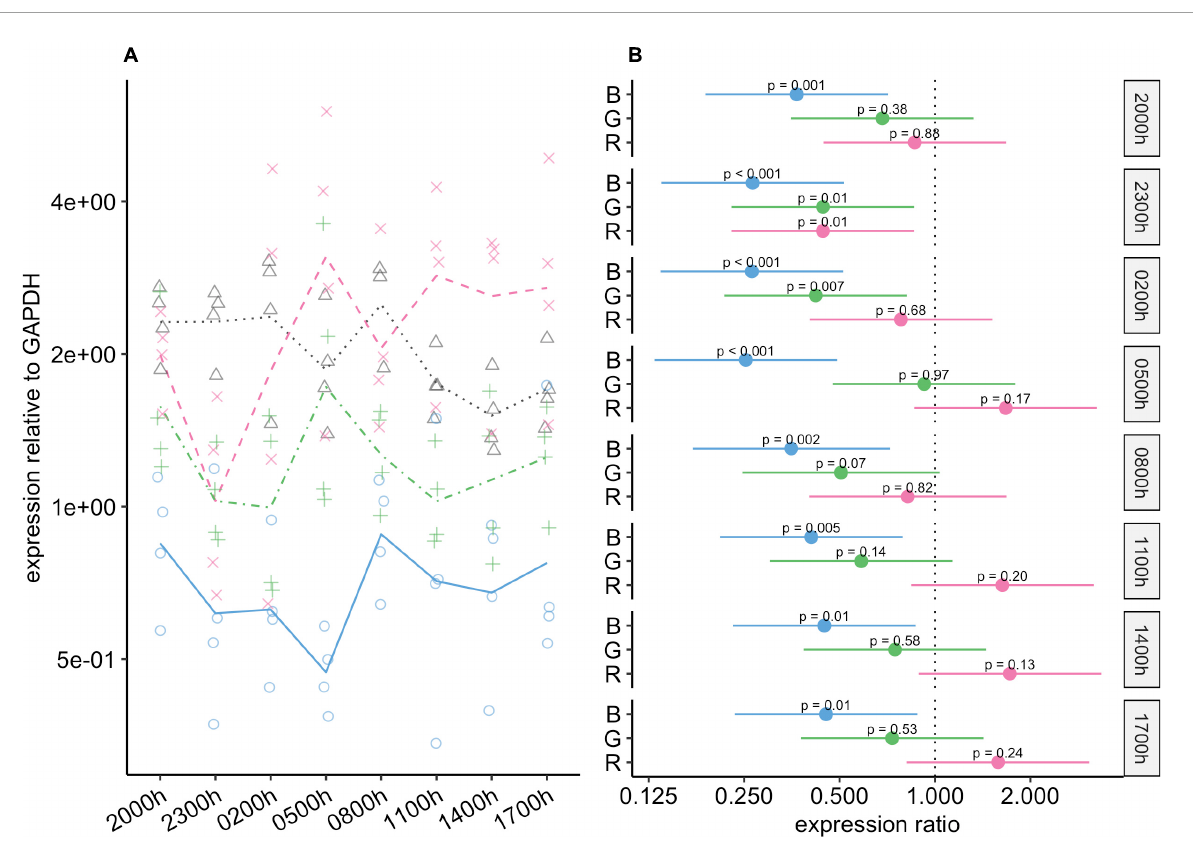
FIGURE4 Effect of monochromatic light exposure on Rho mRNA expression in the retinas of Wistar rats. Experimental details were the same as in Figure 1 . P -values and 95% confidence intervals were calculated with Dunnett’s test. Note that logarithmic scales are used. (A) Points show gene expression levels in individual rats; lines connect mean values in each group. To facilitate viewing by color-blind readers, different points and line types were used: control group, dotted line ( •• ) and triangles; red-light group, dashed line (– –) and x-marks; green-light group, dot-dash line ( • –) and crosses; blue-light group, solid line and circles. (B) Points show differences between group means; error bars show the 95% confidence interval for each difference. Abbreviations indicate which group is being compared to the control group: B, blue-light group; G, green-light group; R, red-light